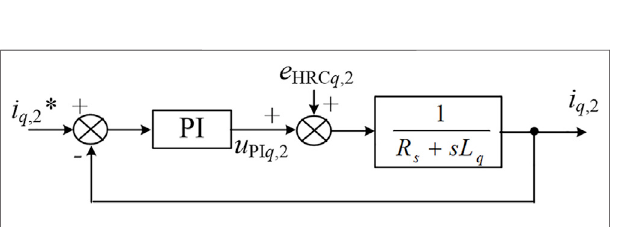
FIGURE 5 | 2nd-order components in q-axis current control diagram.